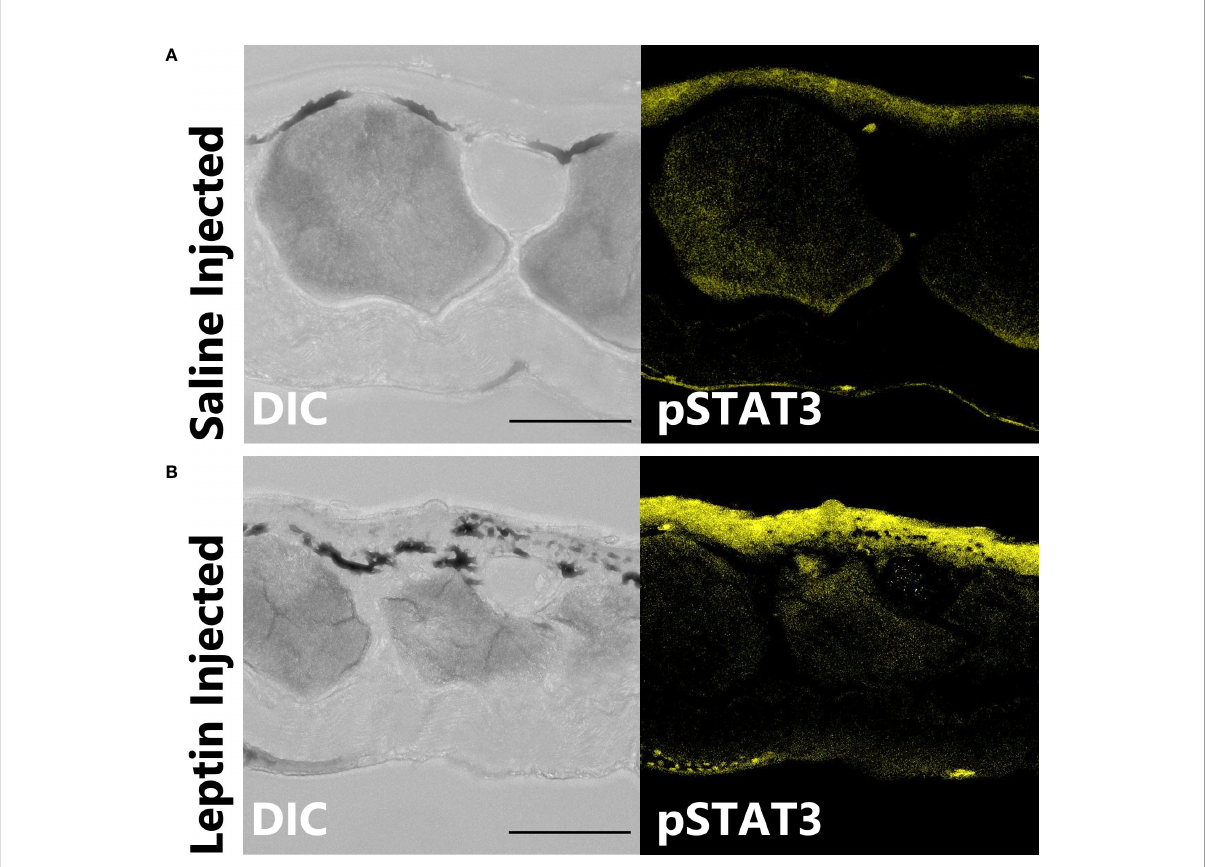
FIGURE 2 Leptin stimulates JAK/STAT signaling in skin. Leptin-induced phosphorylated STAT3-ir (pSTAT3-ir, yellow) in 16-µm sections of juvenile Xenopus laevis dorsal skin; skin was fi xed 6 h after intraperitoneal injection with (A) saline or (B) leptin. Leptin stimulates pSTAT3-ir strongly in the epidermis and at the apical end of the granular glands and hypodermis (representative image from n = 3). Scale bar, 100 µm ( n = 3). Epidermis (E), dermis (D), stratum corneum of the dermis (SC), and thin hypodermis (H). Scale bar, 50